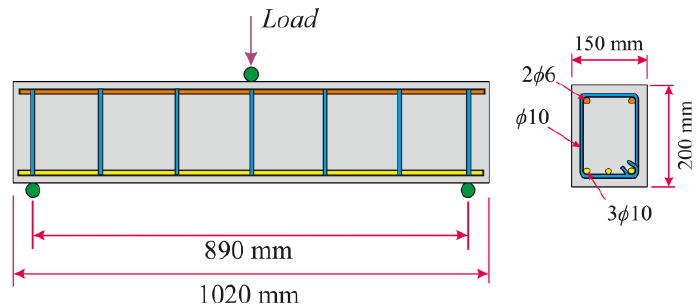
Figure 2. Reinforcement detailing and flexural test setup.